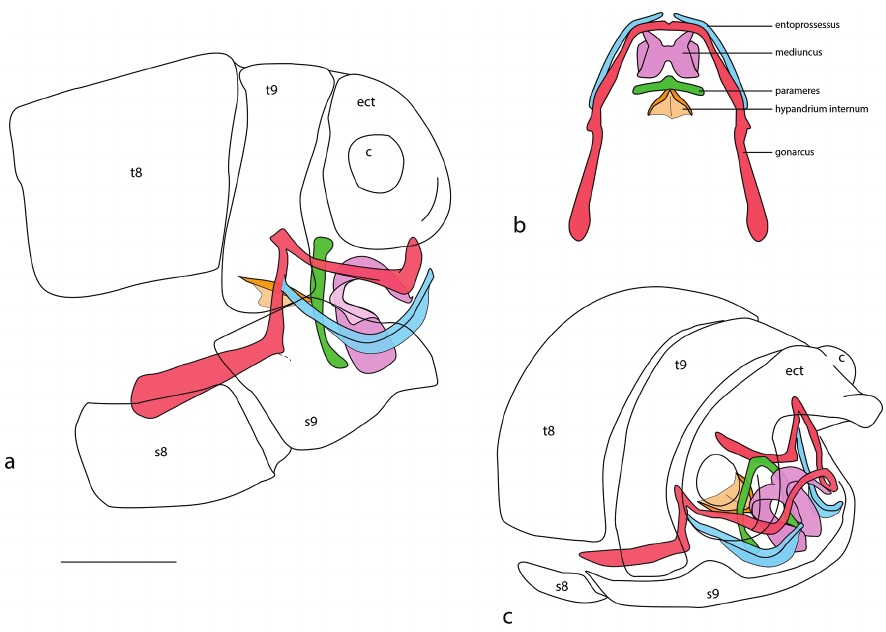
Figure 5. Male genitalia of Gryposmylus pennyi sp. n.: A lateral view B dorsal view C oblique view. Colour key: gonarcus (red), ectoprocessus (blue), mediuncus (purple), parameres (green), hypandrium internum (orange). Abbreviations: t8 , tergite 8; s8 , sternite 8; t9 , tergite 9; s9 , sternite 9; ect , ectoproct; c , callus cercus. Scale bar: 0.2 mm.